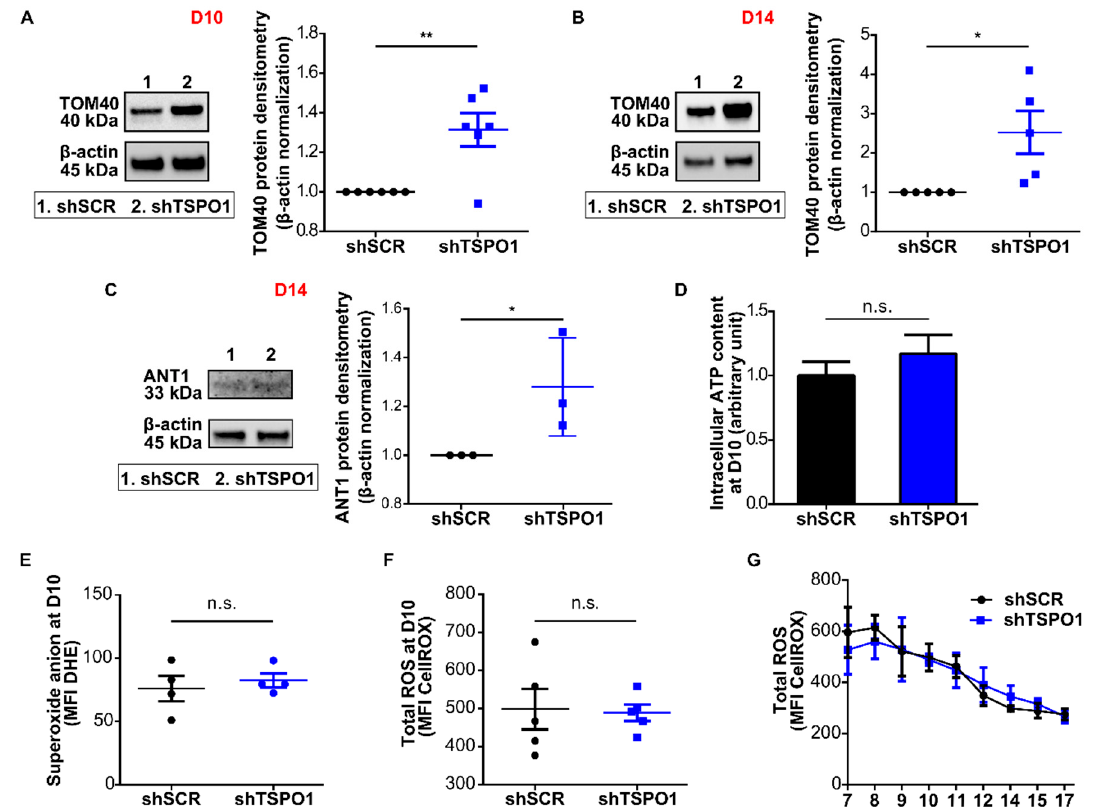
Figure 2. TSPO1 downregulation causes mitochondrial retention. Western blot quantification of TOM40 as mitochondrial mass reporter at ( A ) Day 10 ( n = 6) and ( B ) Day 14 of human erythroid differentiation ( n = 5). ( C ) Western blot quantification of adenine nucleotide transporter (ANT) as mitochondrial mass reporter at Day 14 ( n = 3). Levels in shSCR-transduced cells were arbitrarily set at “1”. * p < 0.05. ( D ) Intracellular adenosine triphosphate (ATP) quantification by luminometry ( n = 3) at Day 10. Level in shSCR-transduced cell was arbitrarily set at “1”. ( E ) Superoxide anion quantification measured at Day 10 of differentiation by flow cytometry (DHE) ( n = 4). ( F ) Total reactive oxygen species (ROS) production quantification measured at Day 10 of differentiation by flow cytometry (CellROX) ( n = 5) at Day 10 and ( G ) all along the differentiation. * p < 0.05, ** p < 0.01, n.s. not statistically significant